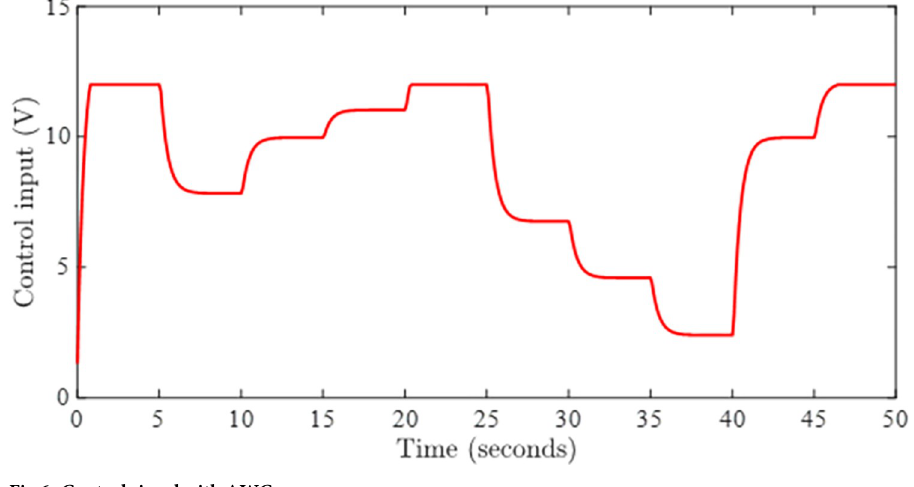
Fig 6. Control signal with AWC.